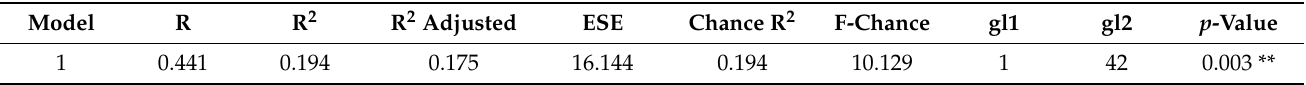
Table 5. Regression analysis of self-compassion on the global health assessed as HRQoL (health-related quality of life) in people with MS. Stepwise method.